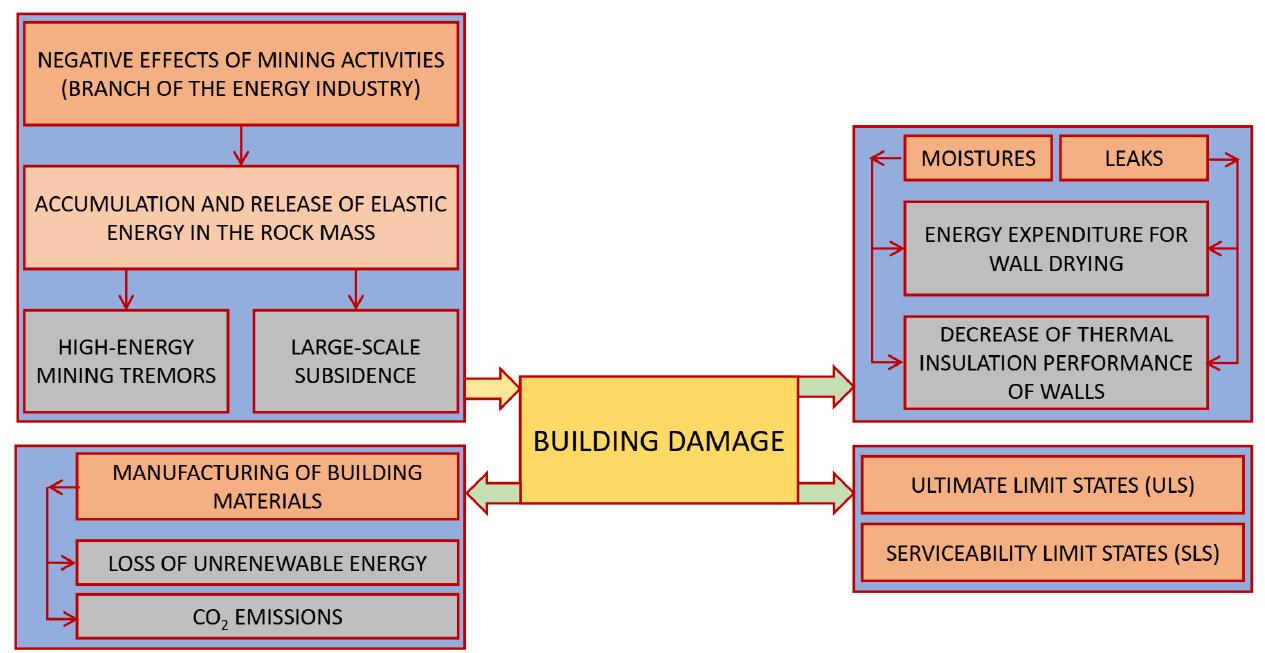
Figure 1. Distribution of data for the variable relating to the year of construction of buildings.